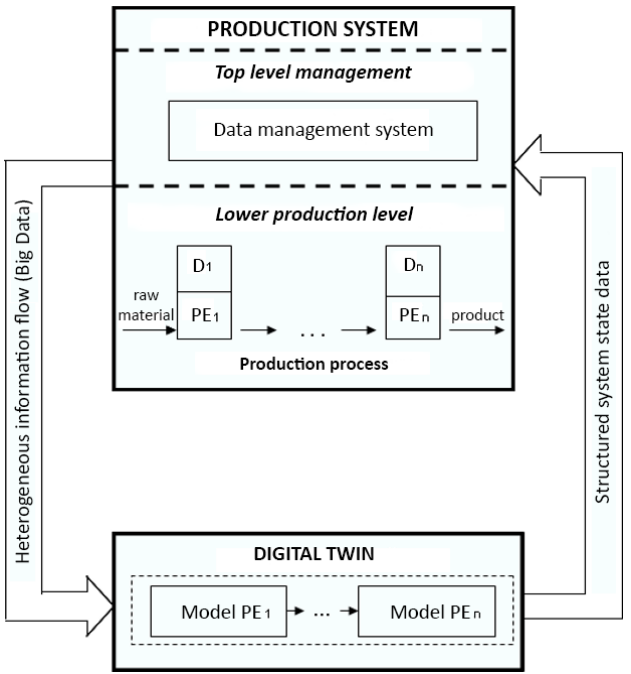
Fig. 4. Production system and its digital